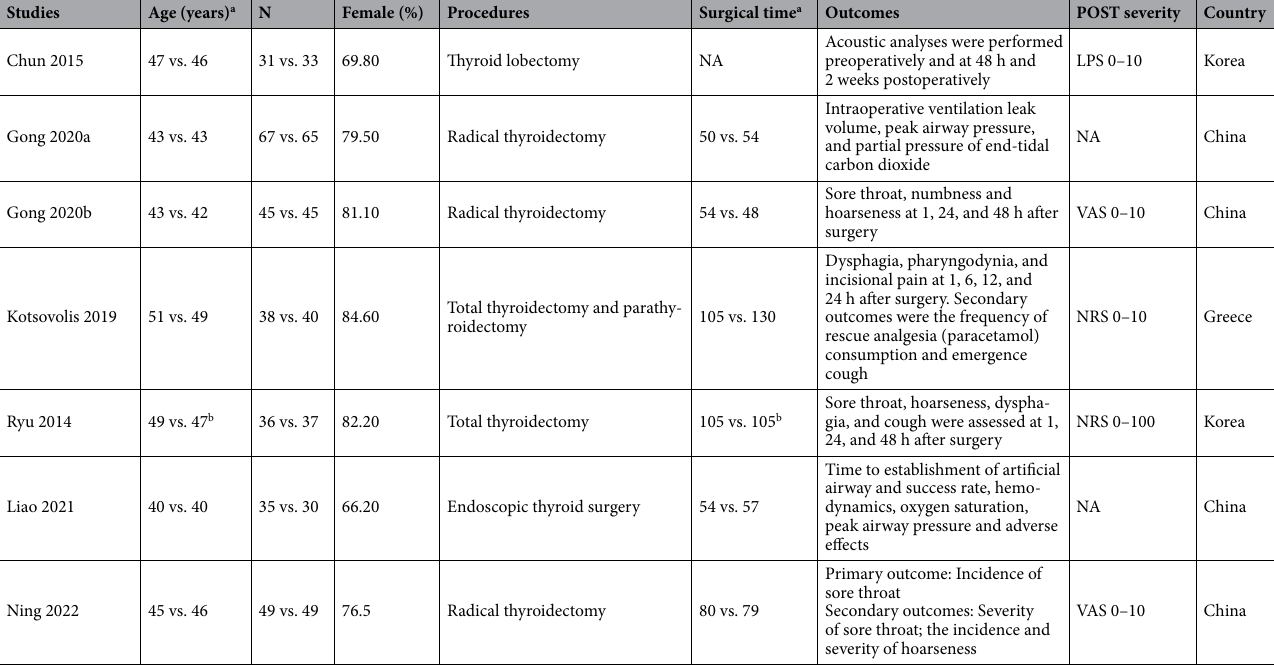
Table 2. Characteristics of studies (n = 7). POST postoperative sore throat, VAS visual analog scale, NRS numerical rating scale, LPS laryngopharyngeal symptom score, NA not available. a Presented as mean; b presented as